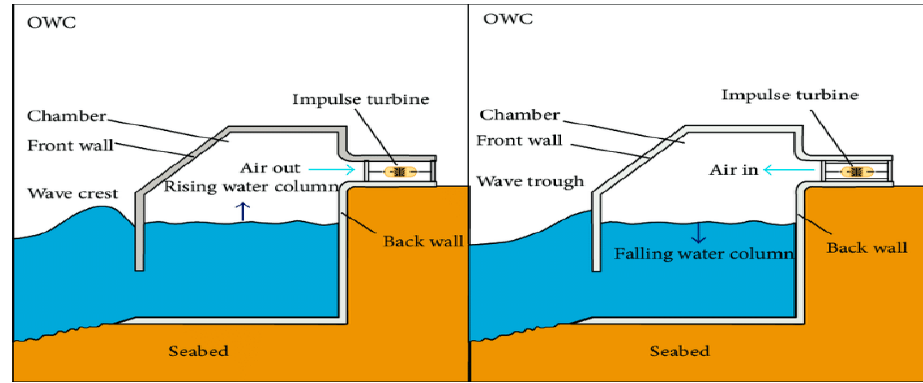
Figure 4. Oscillating water column system.